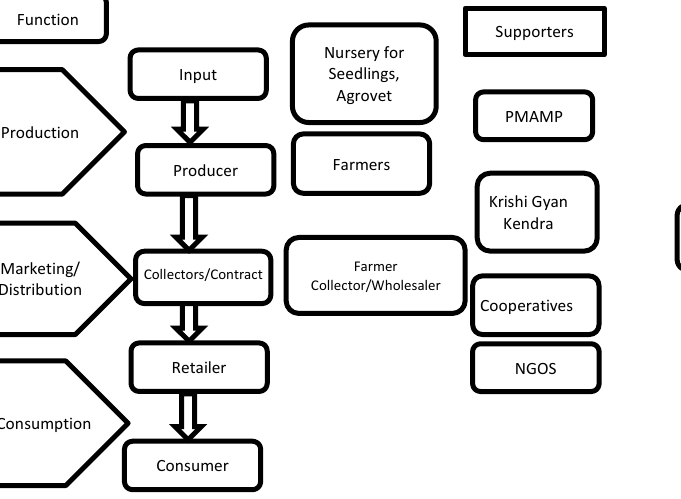
Figure 2: Existing value chain map of Jajarkot district